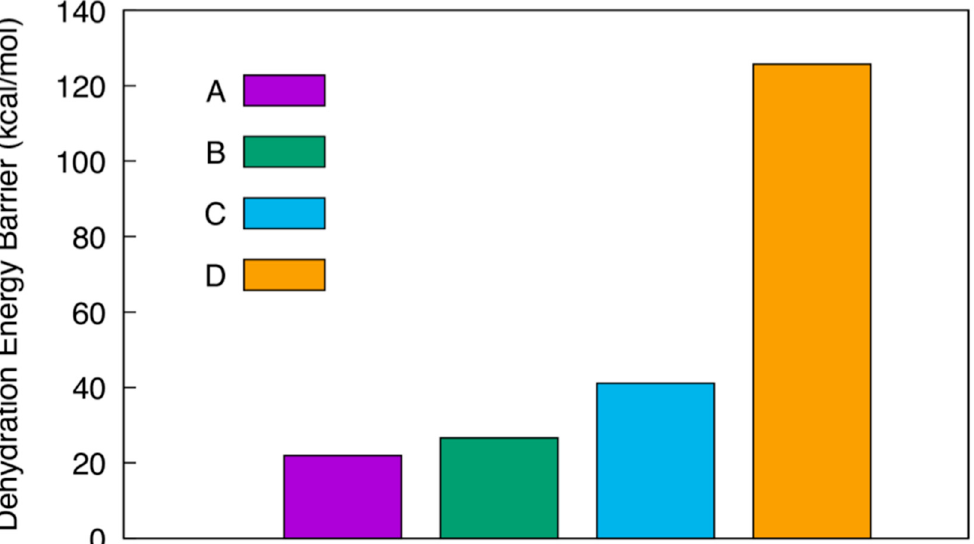
Figure 3. The free energy barrier before the formation of hydrogen bonds between the polymer chains for the four interacting systems (A: DP 20 ionized PSSA, DP 20 Cellulose; B: DP 10 PSSA, DP 10 Cellulose; C: DP 20 PSSA, DP 20 PIL; D: DP 10 PIL, DP 10 Cellulose) in aqueous solution.